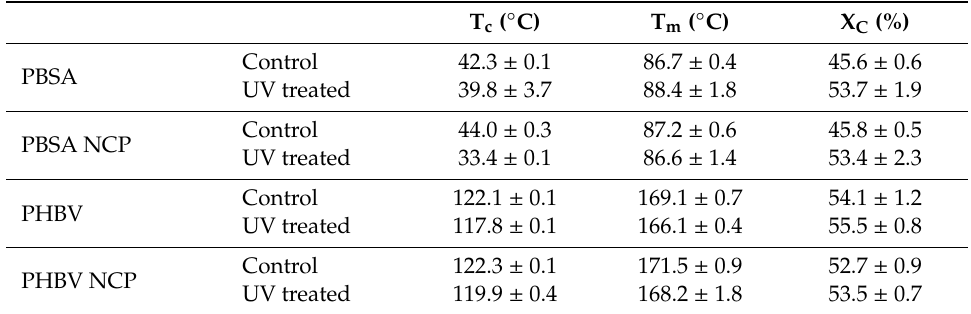
Table 1. Crystallization temperature (T c ), melting temperatures (T m ) and crystallinity degree (X C ) of neat and nanocomposite PBSA and PHBV and the corresponding aged